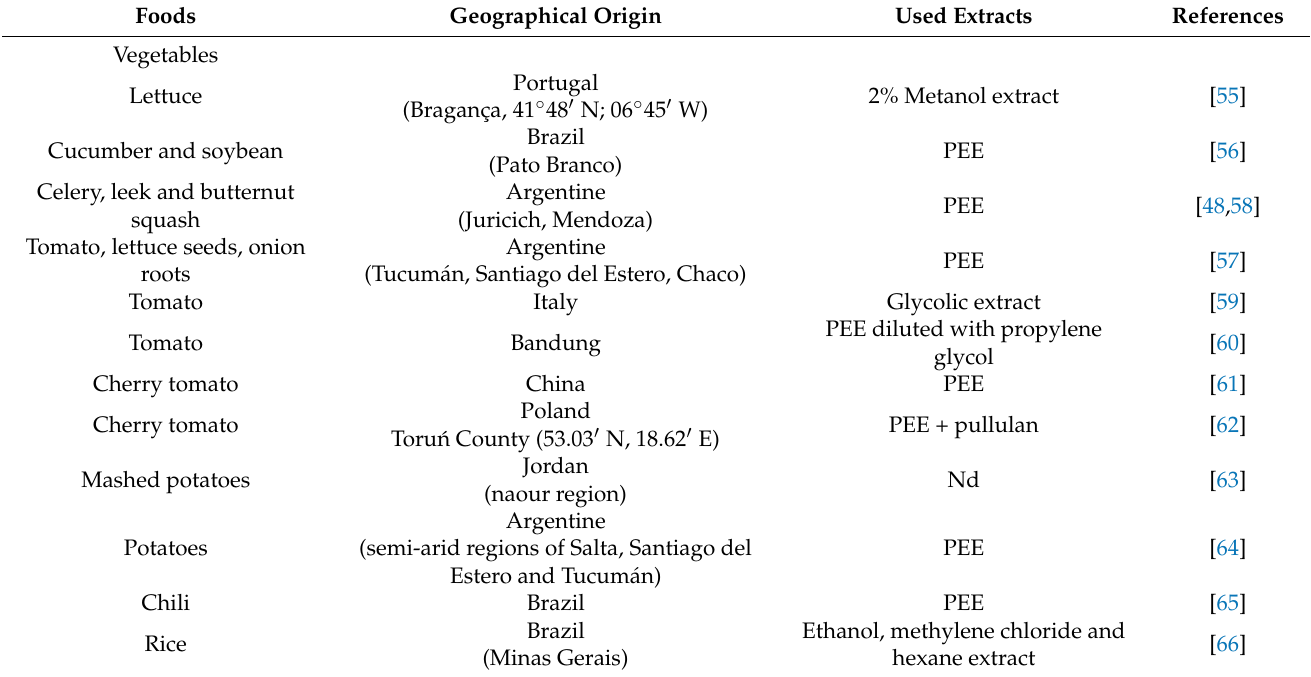
Table 1. Application of propolis extracts in fruits and vegetables. Foods Geographical Origin Used